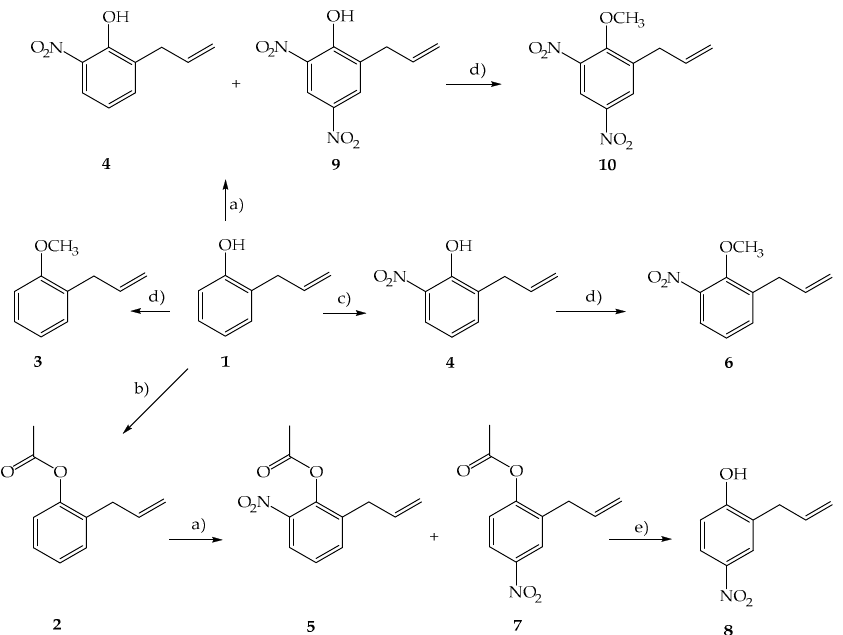
Figure 1. Chemical structures of 2-AP ( 1 ) and new synthesized derivatives ( 2 – 10 ).